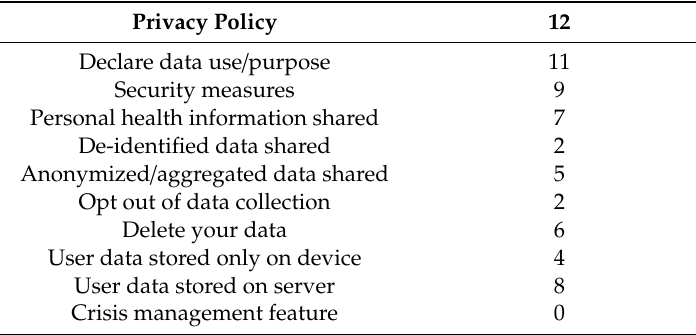
Table 3. Privacy Policies for Contact-Tracing Apps ( N =